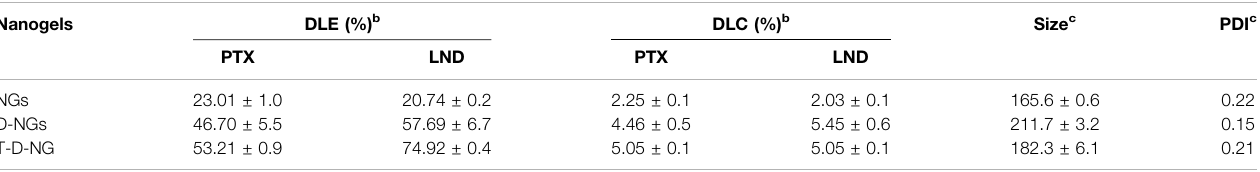
TABLE 1 | Characteristics of different drug-loaded nanogels a